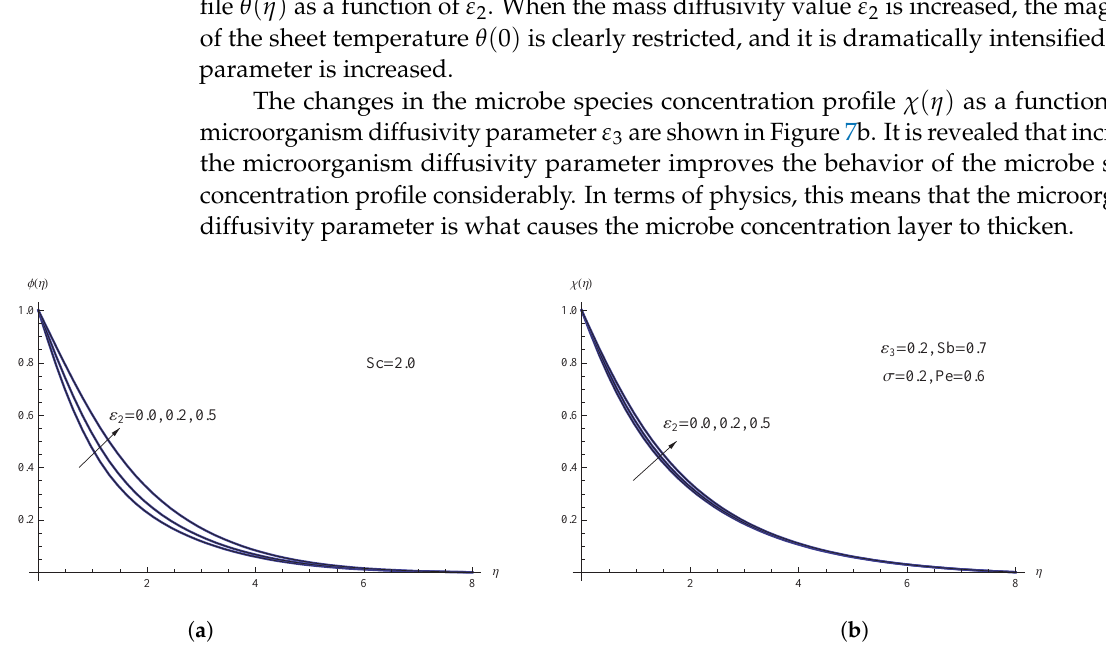
Figure 6. ( a ) φ ( η ) for various ε 2 . ( b ) χ ( η ) for various ε 2